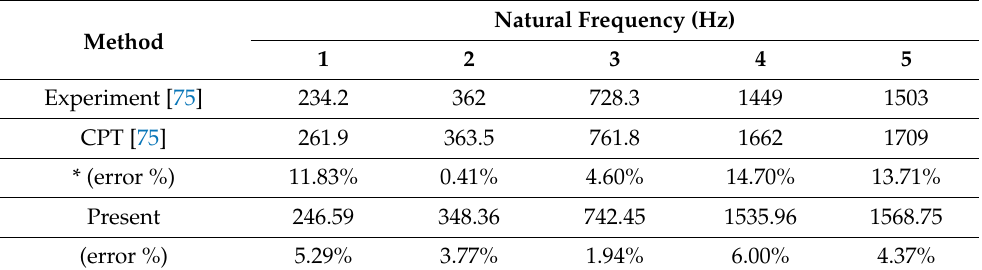
Table 3. Natural frequencies of graphite/epoxy [0 2 , 30, − 30] s square cantilever plate ( a = 76.2 mm, a / h =